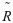
Comparisons on the worst case average improvement of the capacity when disk size R˜ is varied.